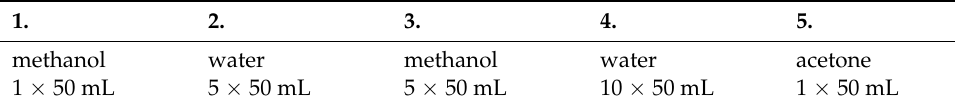
Table 7. Washing steps for core-shell MIP and NIP